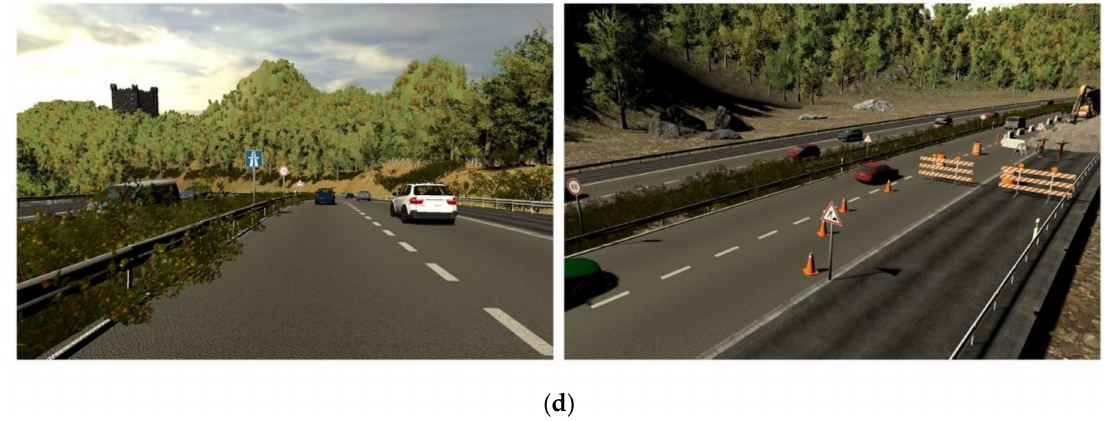
Figure 3. ( a ) Pictures of the different scenes from the mountain road. ( b ) Pictures of the different scenes from the village “Westbrück”. ( c ) Pictures of the different scenes from the country road. ( d ) Pictures of the different scenes from the